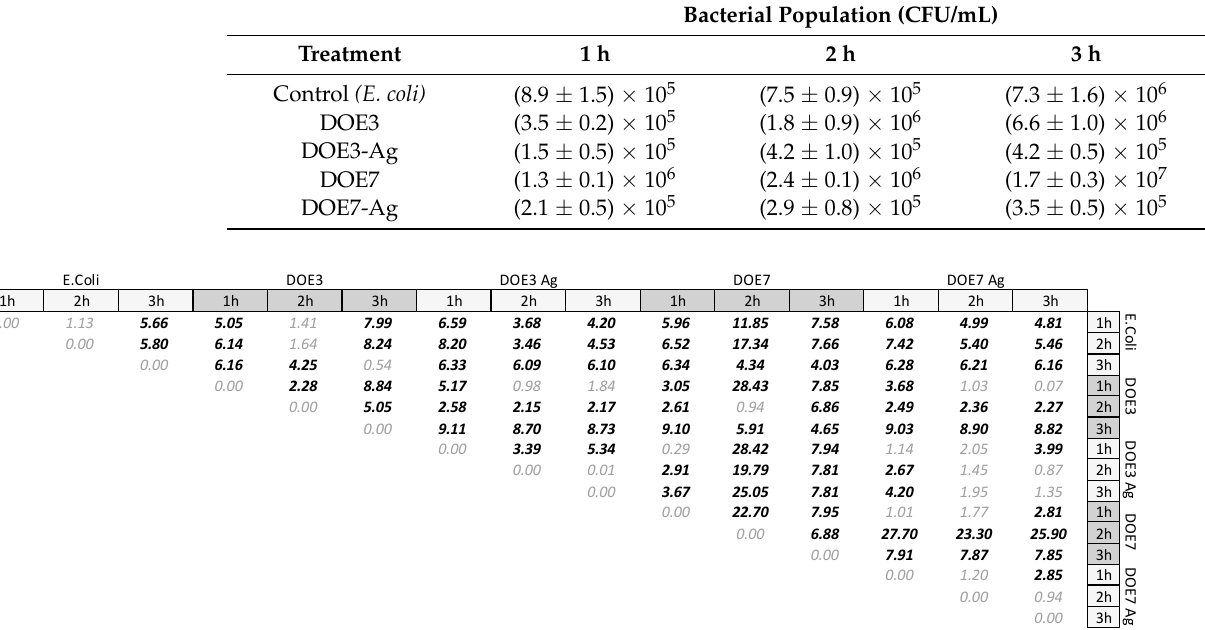
Figure 12. Matrix of Student t-values for mean-pair comparison.